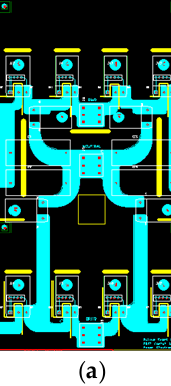
Figure 7. Power stage of proposed active hybrid solid state transformer (AHSST). ( a ) Power board diagram; and, ( b ) Thermal simulation results.